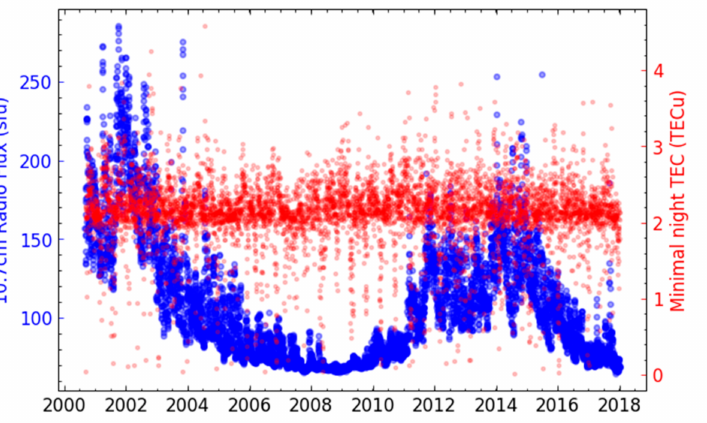
Figure 3. Solar activity expressed as 10.7 cm radio flux (blue) and minimal night ionospheric TEC values at IGS Noto